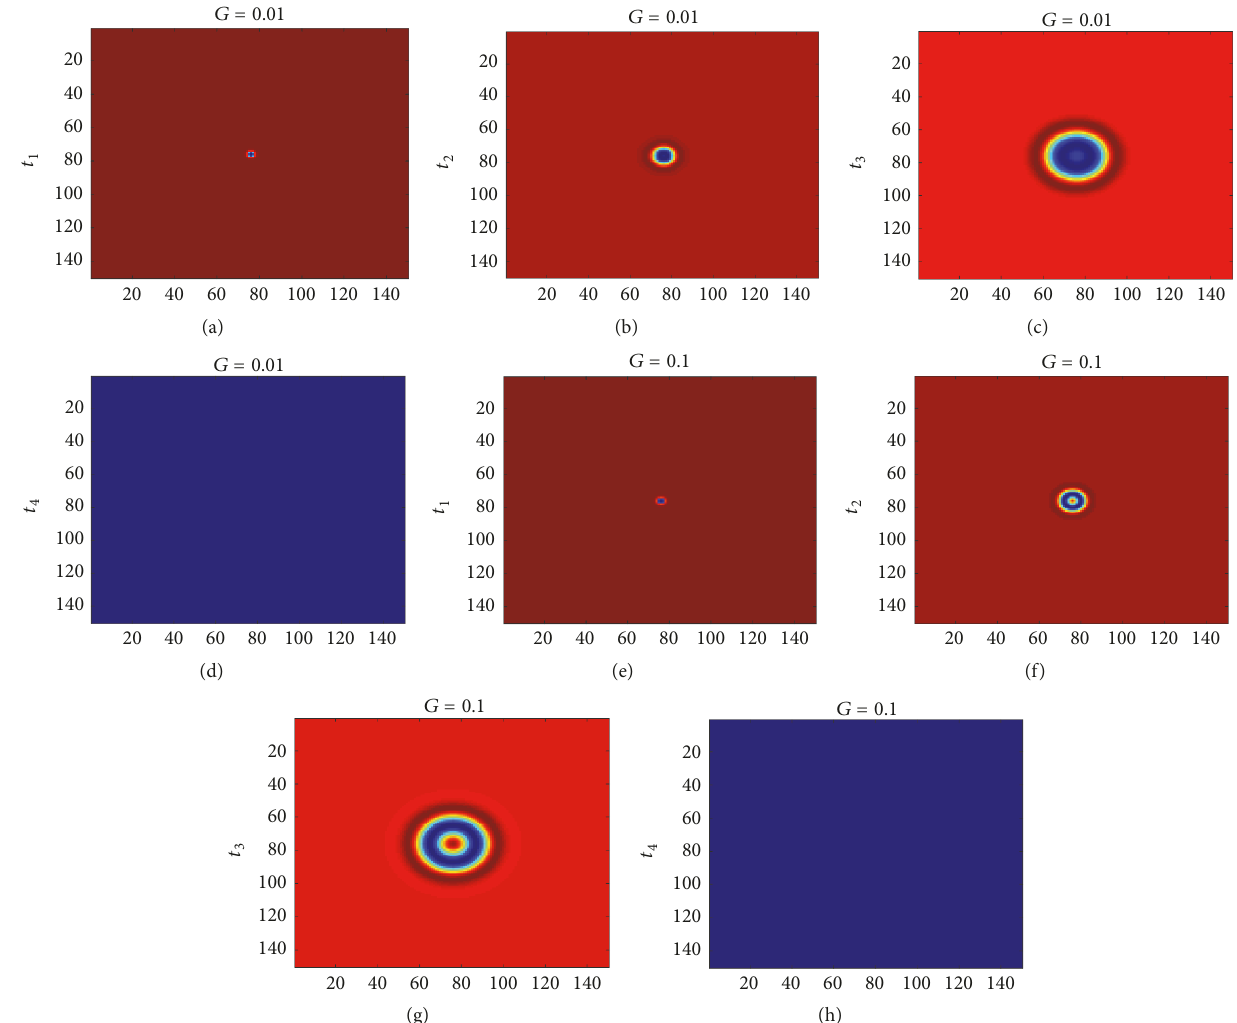
Figure 16: The snapshots of spatial distribution of membrane potential with color scale for neurons in the square array network for 𝑘 = 0.5 and 𝐷 = 1 at 𝑡 1 = 2 time units, 𝑡 2 = 75 time units, 𝑡 3 = 170 time units, and 𝑡 4 = 300 time units. ((a)–(d)) 𝐺 = 0.01 and ((e)–(h)) 𝐺 = 0.1